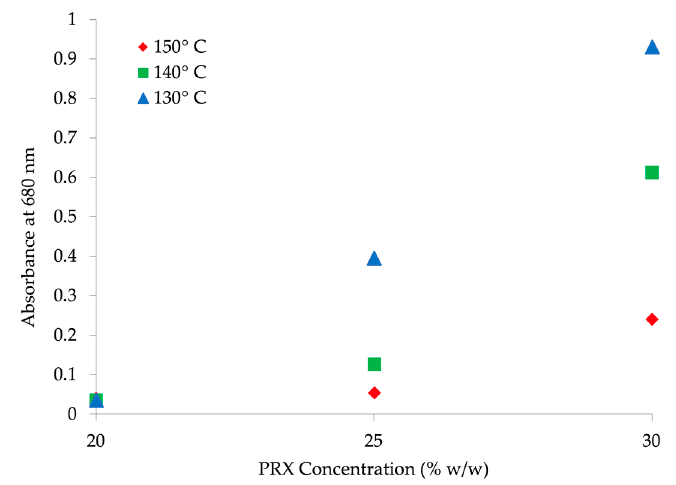
Figure 7. Absorbance at 680 nm vs. API concentration (% w / w ) at 130 °C, 140 °C and 150 °C.